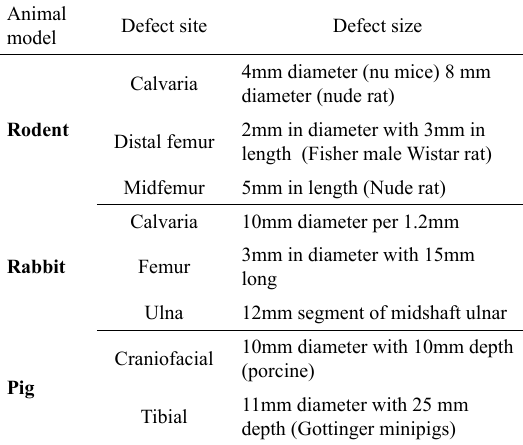
Table 1. Animals models and defect sites/sizes. All values are variable, due to the animals’ age, gender, health and